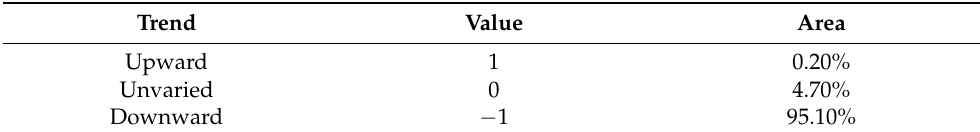
Figure 7. Temporal variation in average monthly EDI.